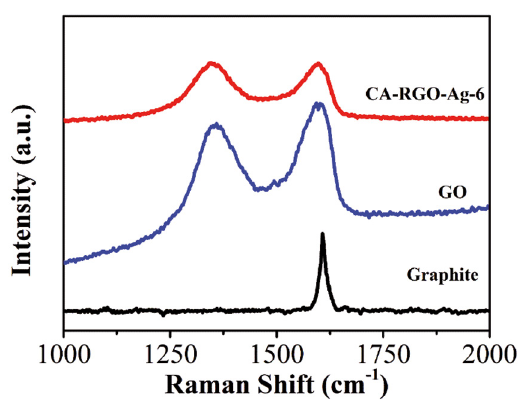
Figure 2: Raman spectra of graphite, GO and CA-RGO-Ag-6.